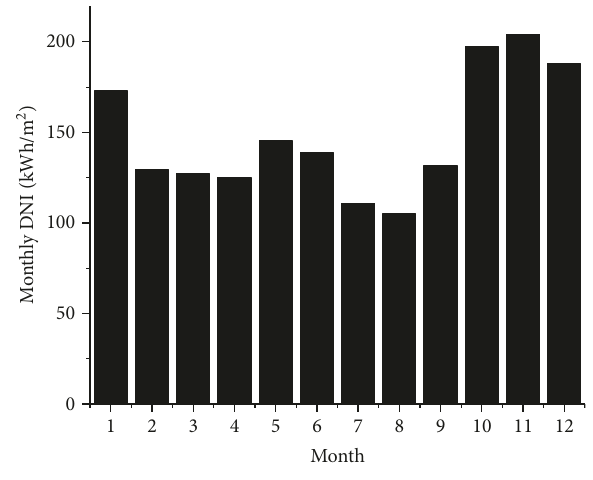
Figure 2: Monthly DNI of Lhasa.